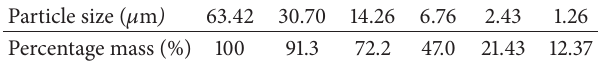
Table 2: Particle size distribution of mineral